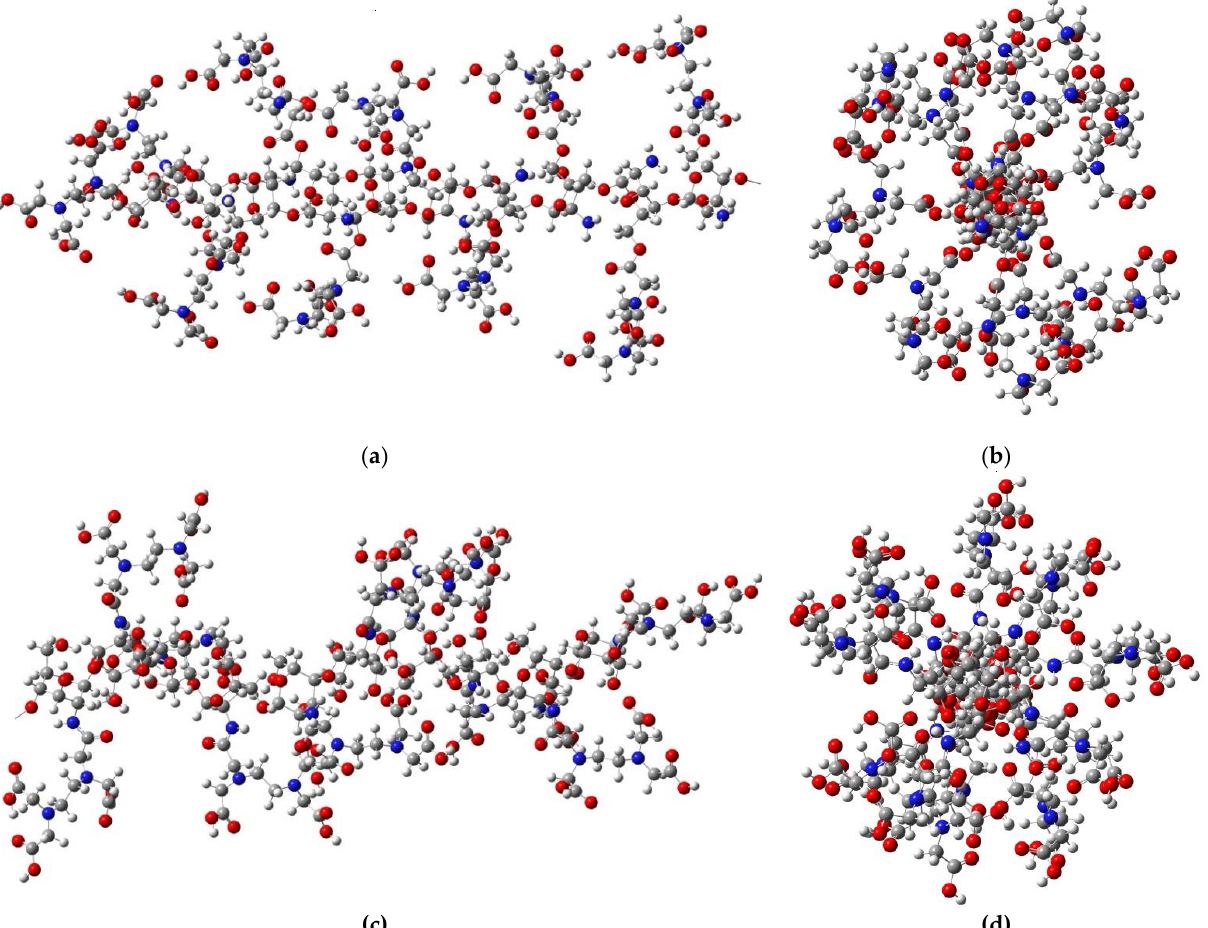
Figure 10. Spatial representation of a structure consisting of ten CS units with EDTA grafted to the hydroxymethyl groups: ( a ) along the chain; ( b ) perpendicular to the chain. Spatial representation of a structure consisting of ten CS units with EDTA grafted to the N atom of the amino groups: ( c ) along the chain; ( d ) perpendicular to the chain.